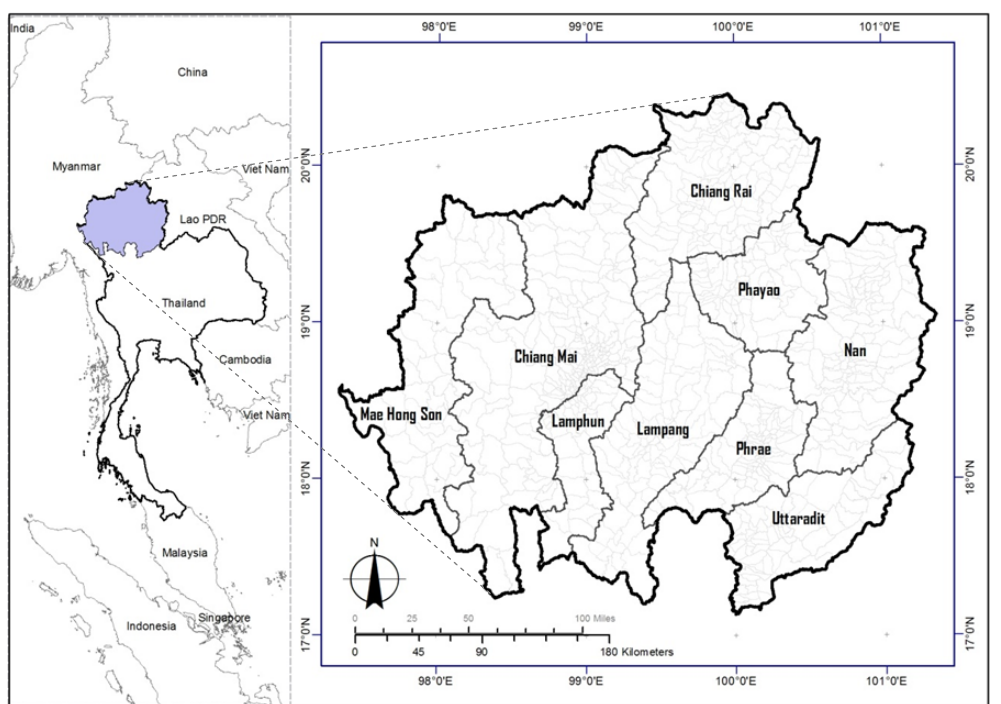
Figure 2. Study area: Upper northern region of